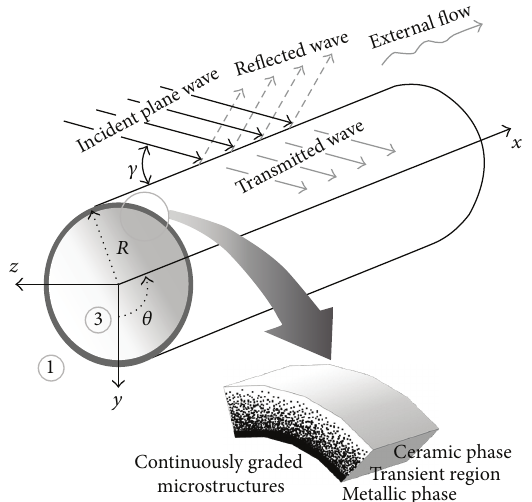
Figure 1: Schematic diagram of the FGM cylindrical